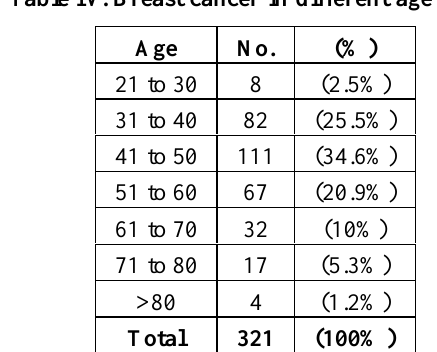
Table IV. Breast cancer in different age group